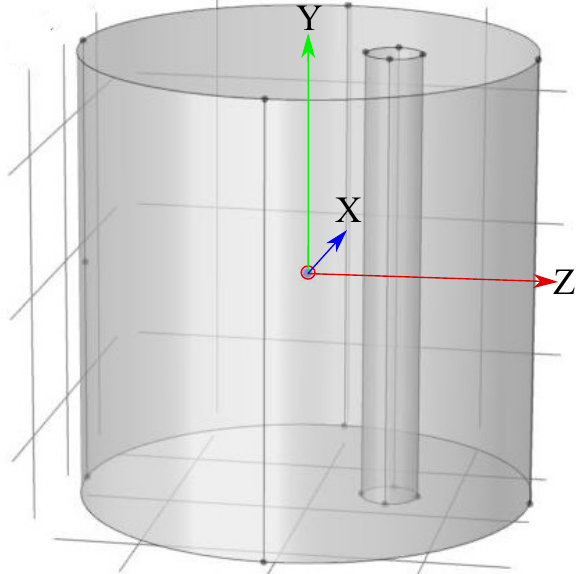
Figure A1. 3D domain for computing the reflections by the cylinder of both the electric fields of the dipoles and the velocity field of the